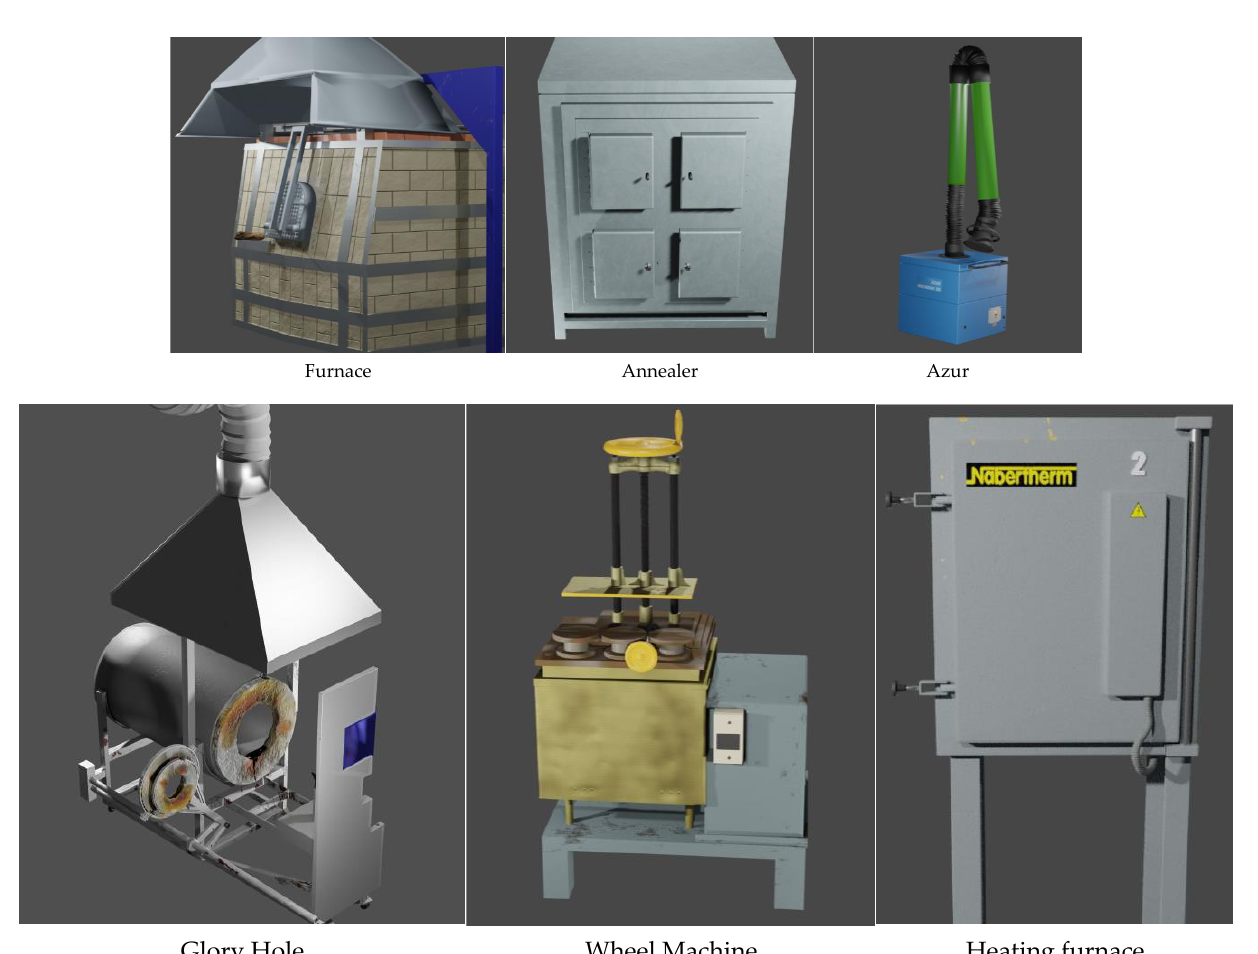
Figure 12. Documentation on the arrangement of machinery items at the CERFAV workshop.